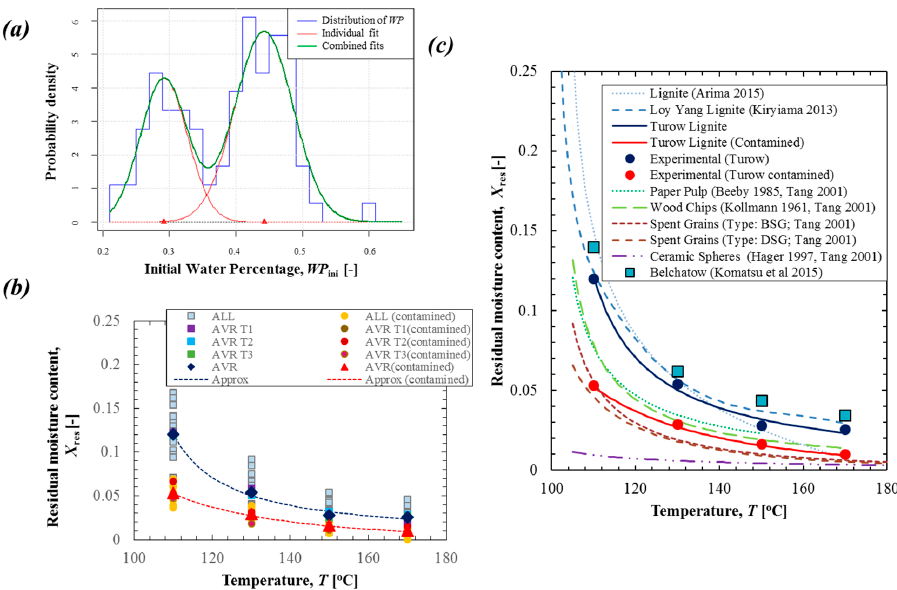
Figure 16. ( a ) Probability density of the distribution of the WP ini of Turow lignite samples; ( b ) residual moisture content in Turow lignite; and ( c ) comparison of residual moisture content in various materials based on data from the literatures [9,16,18,27–30] .